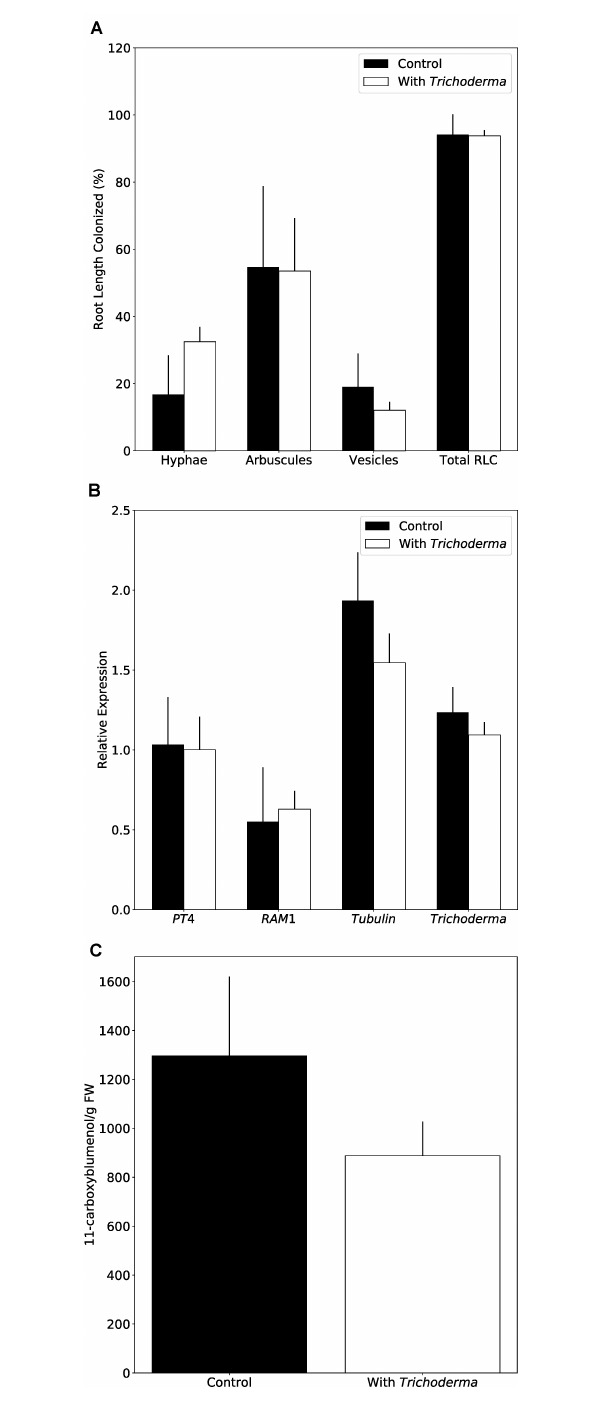
FIGURE 8 | Trichoderma does not interfere with mycorrhiza formation on N. attenuata . (A) AMF colonization 8 weeks after inoculation with or without Trichoderma and AMF simultaneously. Error bars represent SEs from three independent biological replicates. Statistical significance was determined by Welch Two Sample t -test between control and co-culture treatments and was not significantly different. RLC, Root length colonization. (B) AMF marker gene expression determined by qPCR. PT4 , Phosphate transporter 4; RAM1 ,